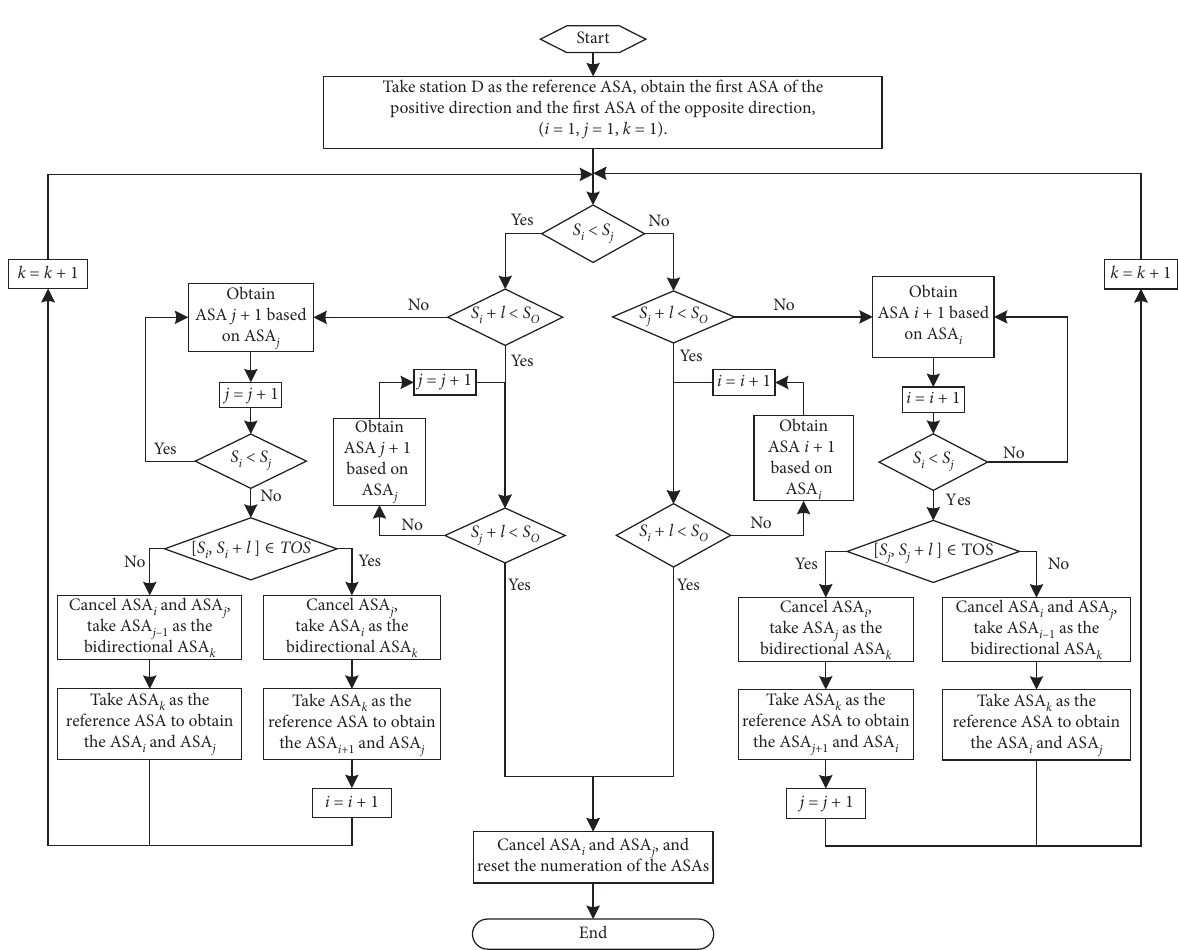
Figure 12: ASA two-way coordination layout